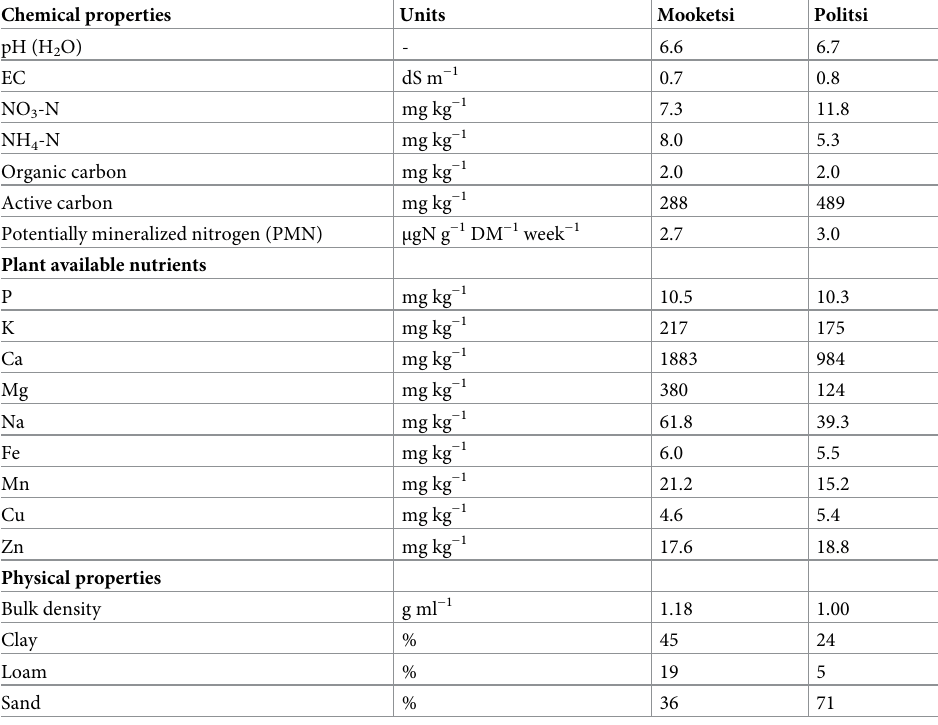
Table 2. Selected chemical and physical soil properties at the Mooketsi and Politsi avocado orchards before appli- cation of the compost. (n = 4). Chemical